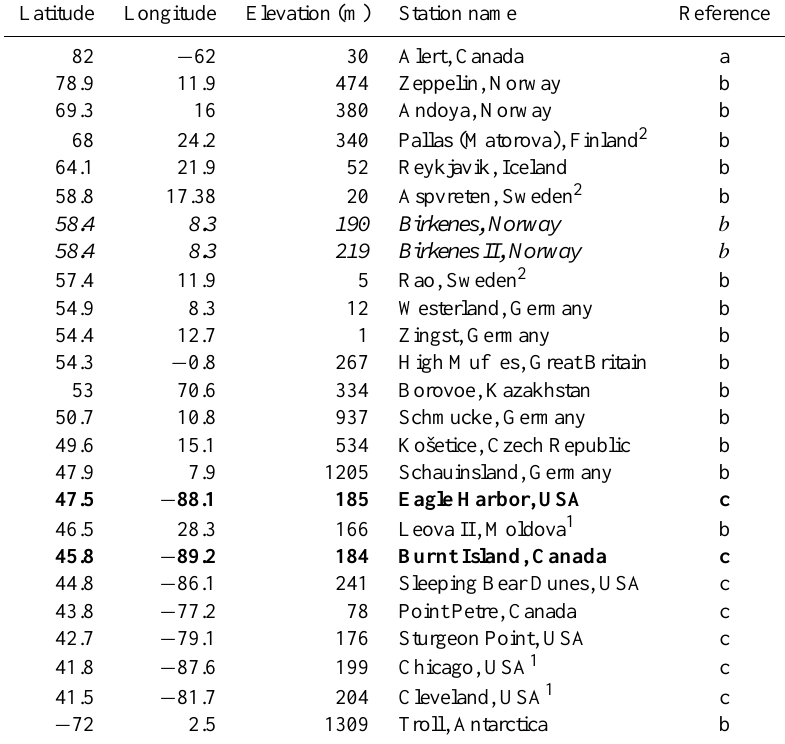
Table 1. Stations where observational data were obtained; first four sites are considered Arctic. References: (a) Hayley Hung/Northern Contaminants Program, personal communication; (b) EMEP (Cooperative Programme for Monitoring and Evaluation of the Long-range Transmissions of Air Pollutants in Europe); (c) Helena Dryfout-Clark/IADN (Integrated Atmospheric Deposition Network), Environment Canada, personal communication. 1 Site considered urban and not included in model–measurement comparison. 2 Site where total deposition is measured. Sites listed in bold/italics were averaged as they occurred within the same model grid box.